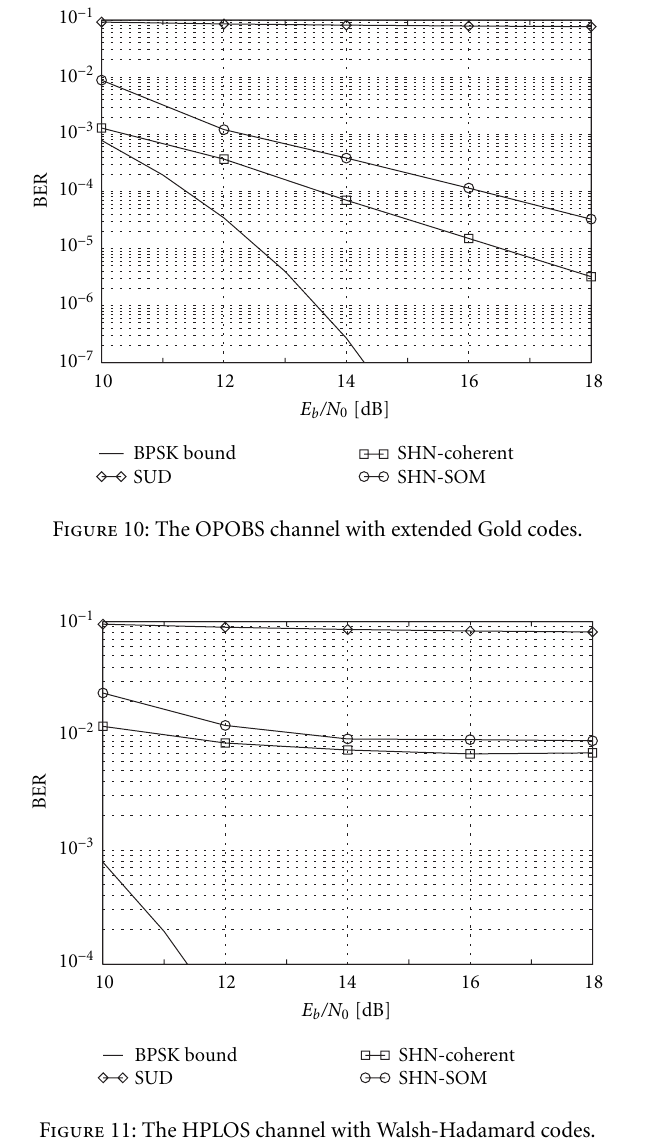
Figure 11: The HPLOS channel with Walsh-Hadamard codes.